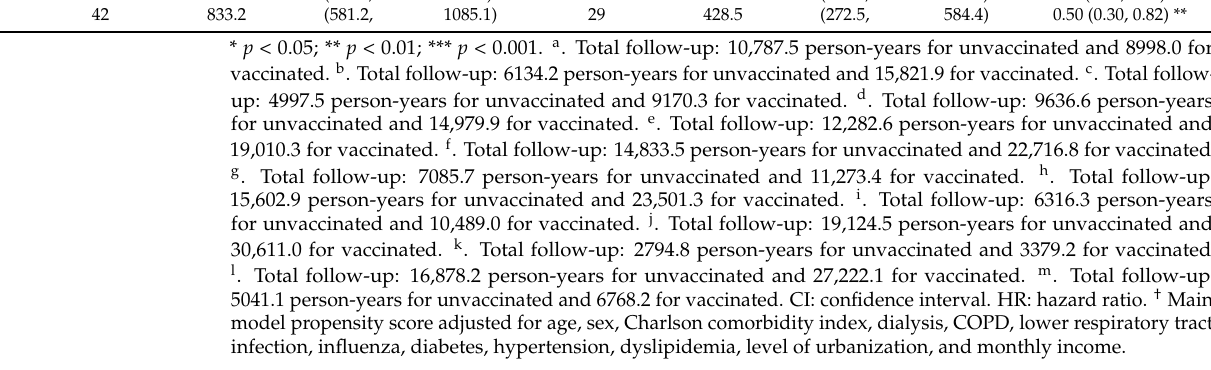
Table 3. Sensitivity Analysis of Adjusted HRs of Vaccination for Risk Reduction in Lung